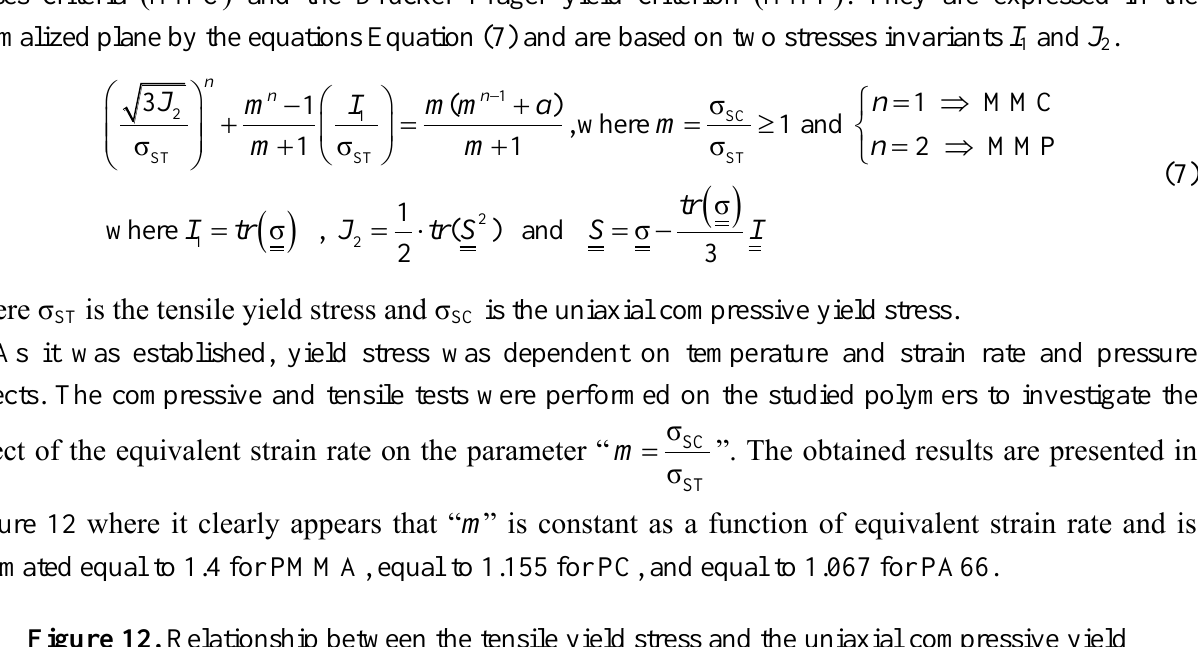
Figure 12. Relationship between the tensile yield stress and the uniaxial compressive yield stress as a function of equivalent strain